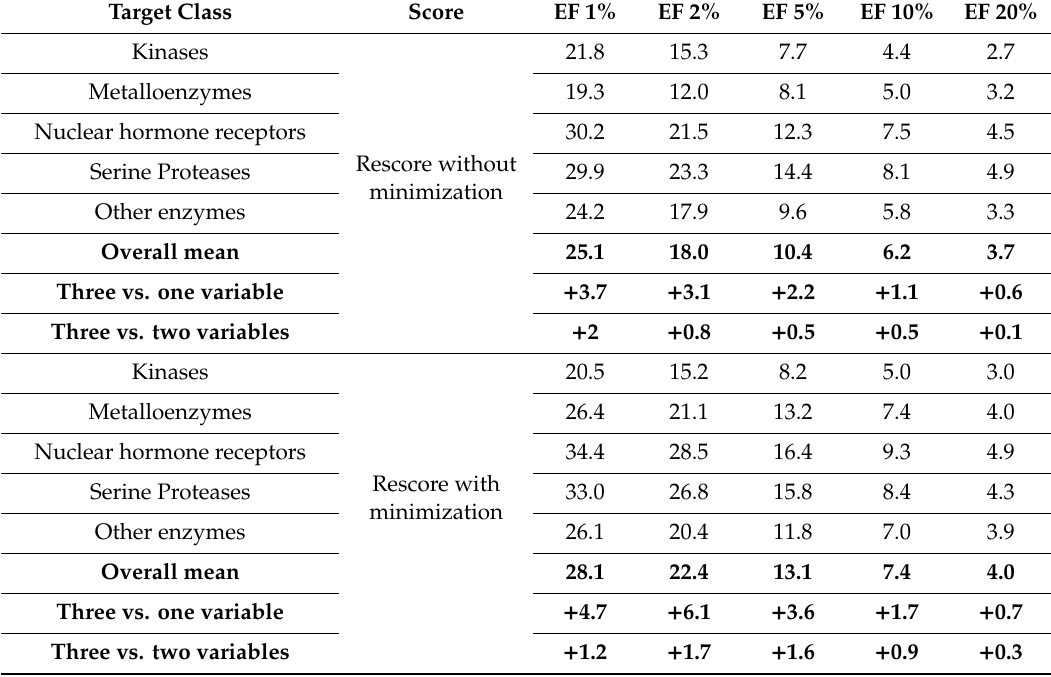
Table 3. Enrichment factor averages for the three-variable equations as generated by the EFO